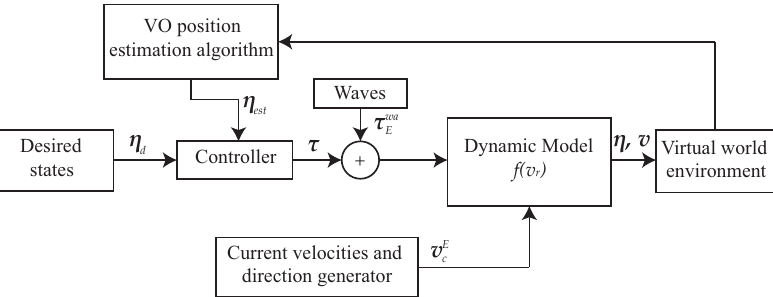
Figure 2. Block diagram of the proposed control